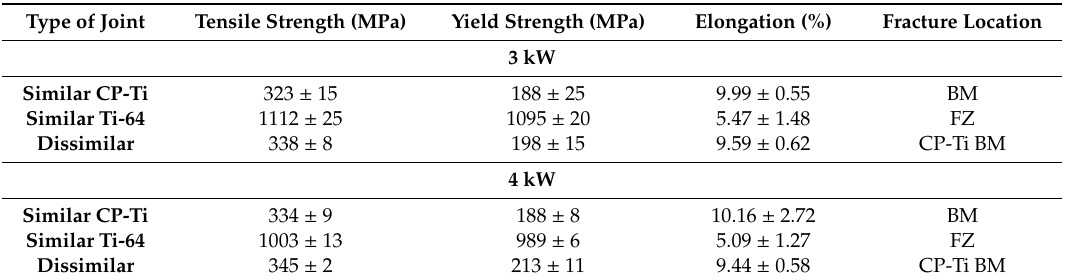
Table 3. Average mechanical properties for all the welded